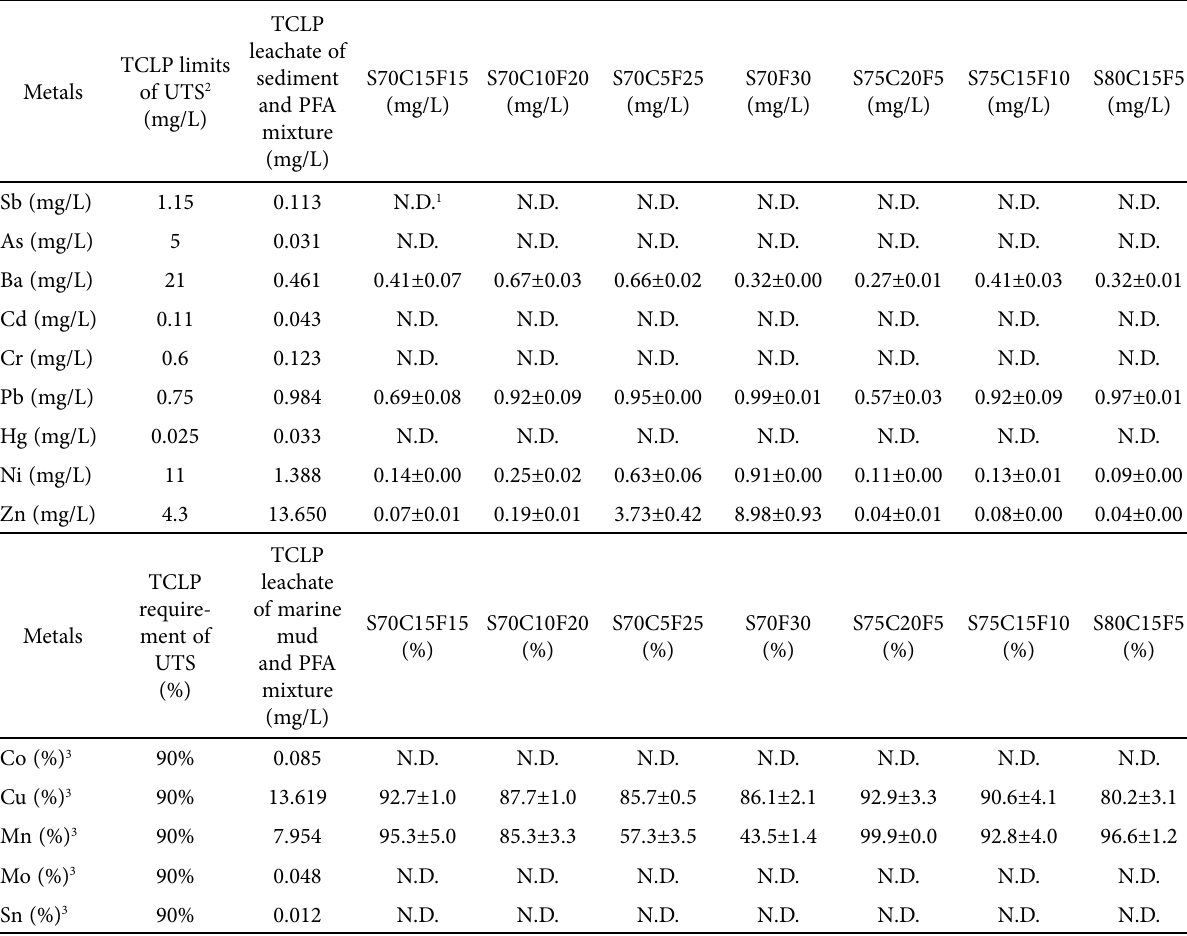
Table 5. TCLP results of S/S treated sediment after 28 days of